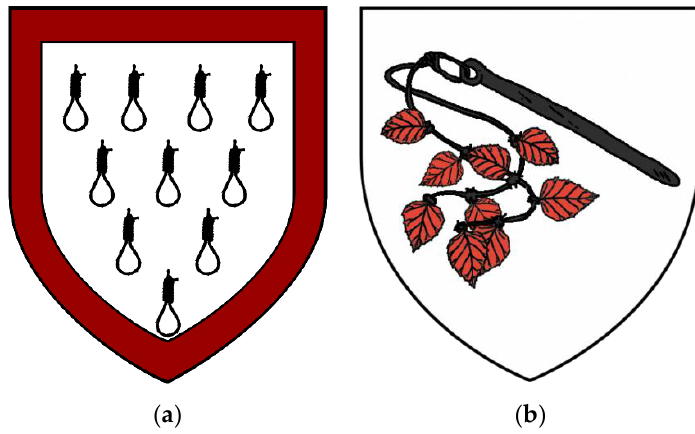
Figure 9. Arms of the Iron Islands showing grim blazons. ( a ) House Myre; ( b ) House Tawney (A Wiki of Ice and Fire (File: Tawney.png) 2014).